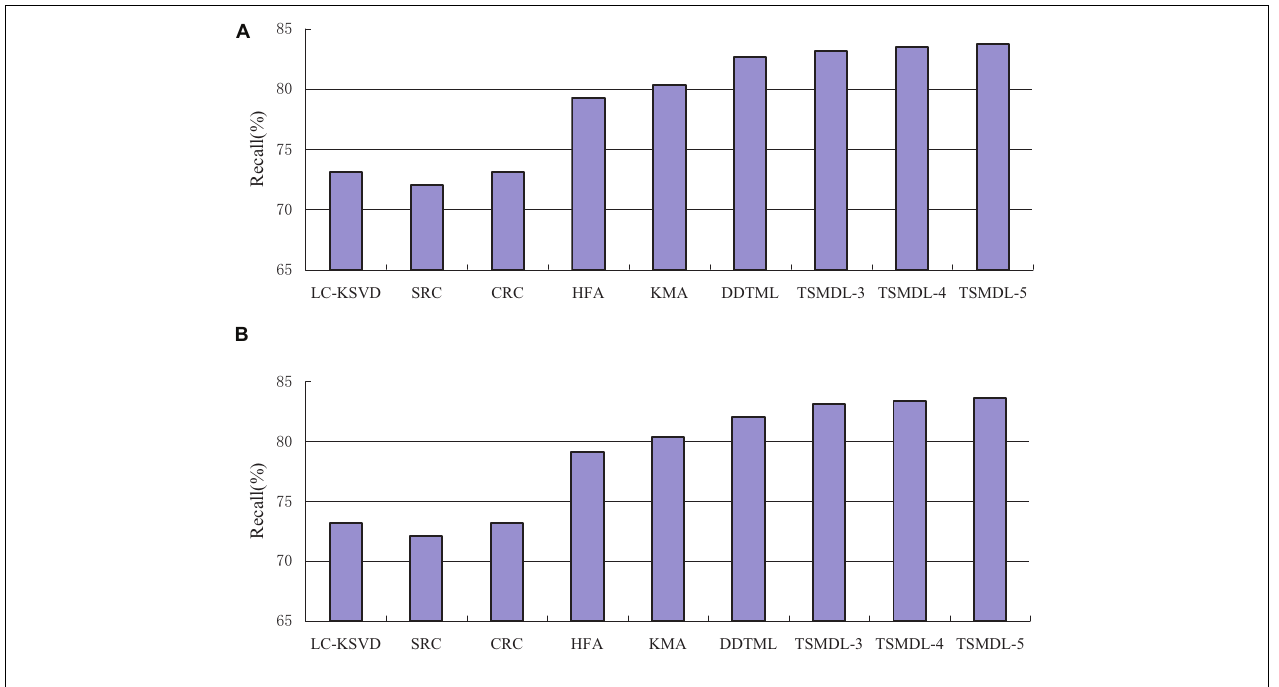
FIGURE 6 | Recall comparison results on tasks, (A) T1, (B) T2